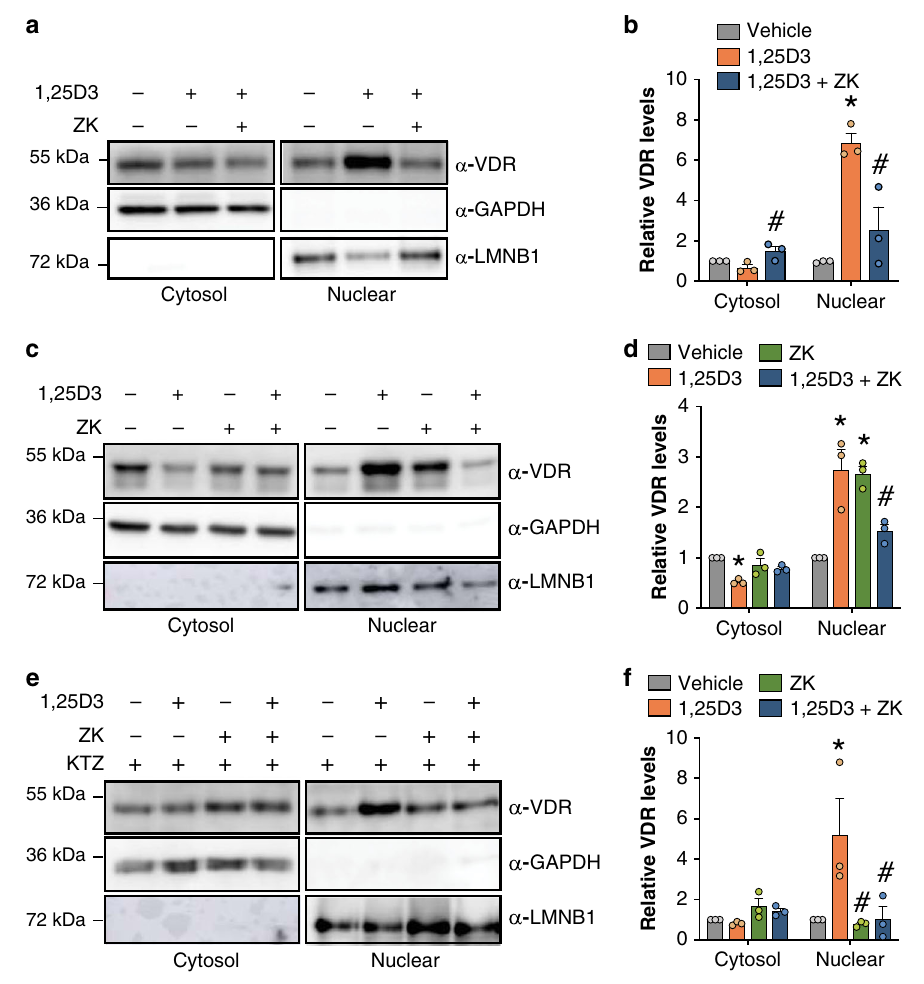
Fig. 3 Ligand-dependent VDR subcellular localization. Representative immunoblot ( a ) and quanti fi cation ( b ) of cytosolic and nuclear VDR in FB-789 cells treated for 1.5 h with vehicle, 10 nM 1,25D3, or 10 nM 1,25D3 and 100 nM ZK. GAPDH and LMNB1 were used as internal controls. n = 3 independent biological replicates/condition. Representative immunoblot ( c and e ) and quanti fi cation ( d and f ) of cytosolic and nuclear VDR in extracts of IEC-18 cells treated for 1.5 h with vehicle, 100 nM 1,25D3, 1 µ M ZK, or 100 nM 1,25D3 and 1 µ M ZK, pre-treated ( e and f ) or not ( c and d ) with 5 µ M ketoconazole (KTZ) for 2 h. GAPDH and LMNB1 were used as internal controls. n = 3 independent biological replicates/condition. Unprocessed blots in Source Data. Data in ( b ), ( d ), and ( f ) are represented as mean + s.e.m. * p < 0.05 vs. vehicle, # p < 0.05 vs. 1,25D3; two-way ANOVA with Tukey post-hoc test. The exact signi fi cant p -values are provided in Supplementary Table regions of Cyp24a1 , Slc30a10 , Slc37a2 , Nkain1 and Atp2b1 28 was